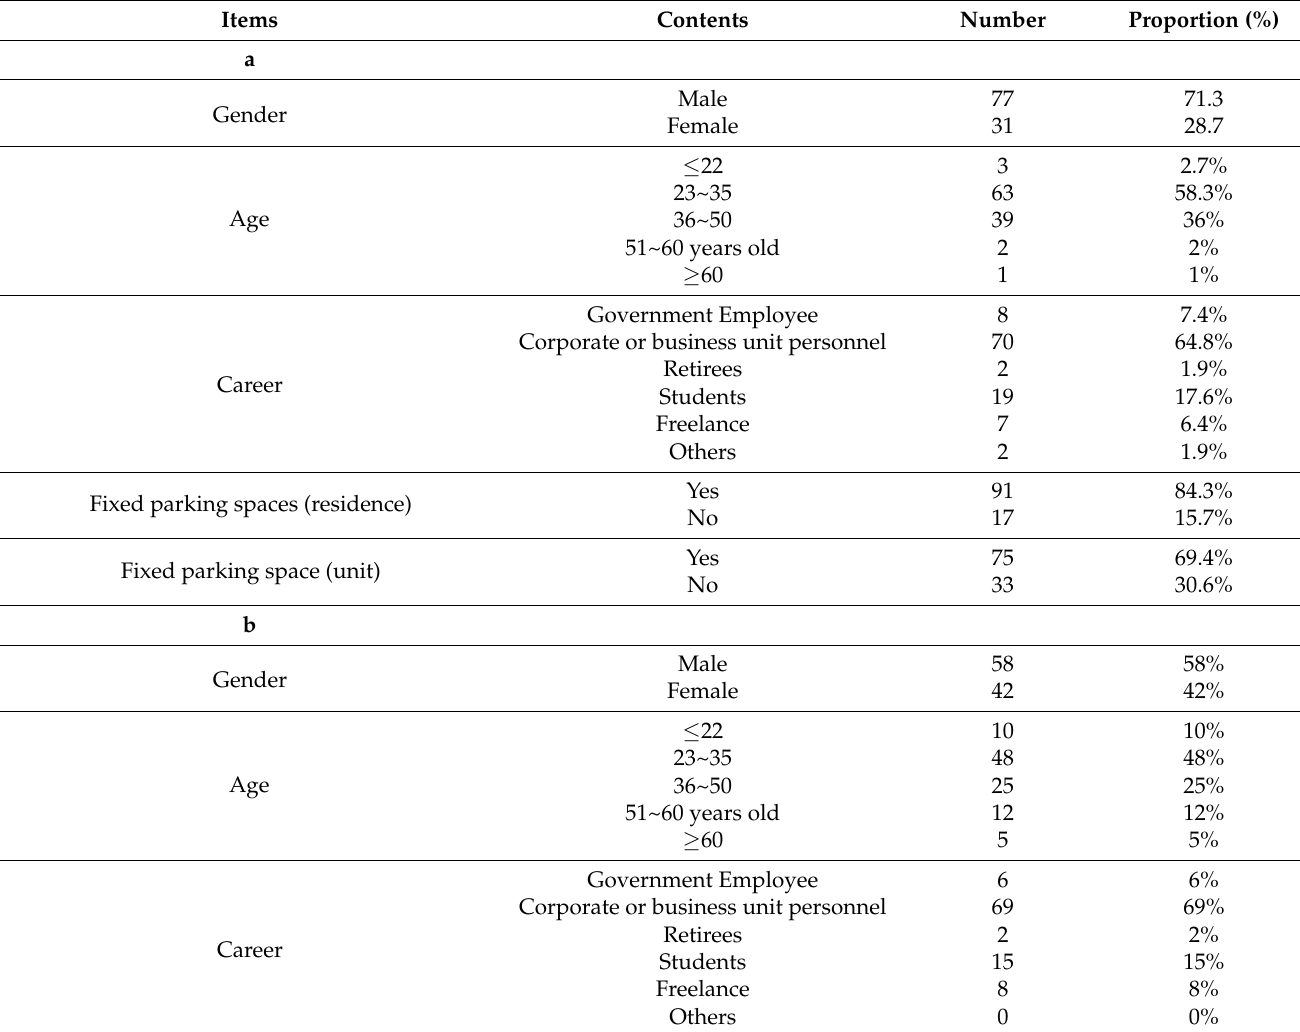
Table 6. ( a ): Basic information of interviewees (driver). ( b ): Basic information of interviewees